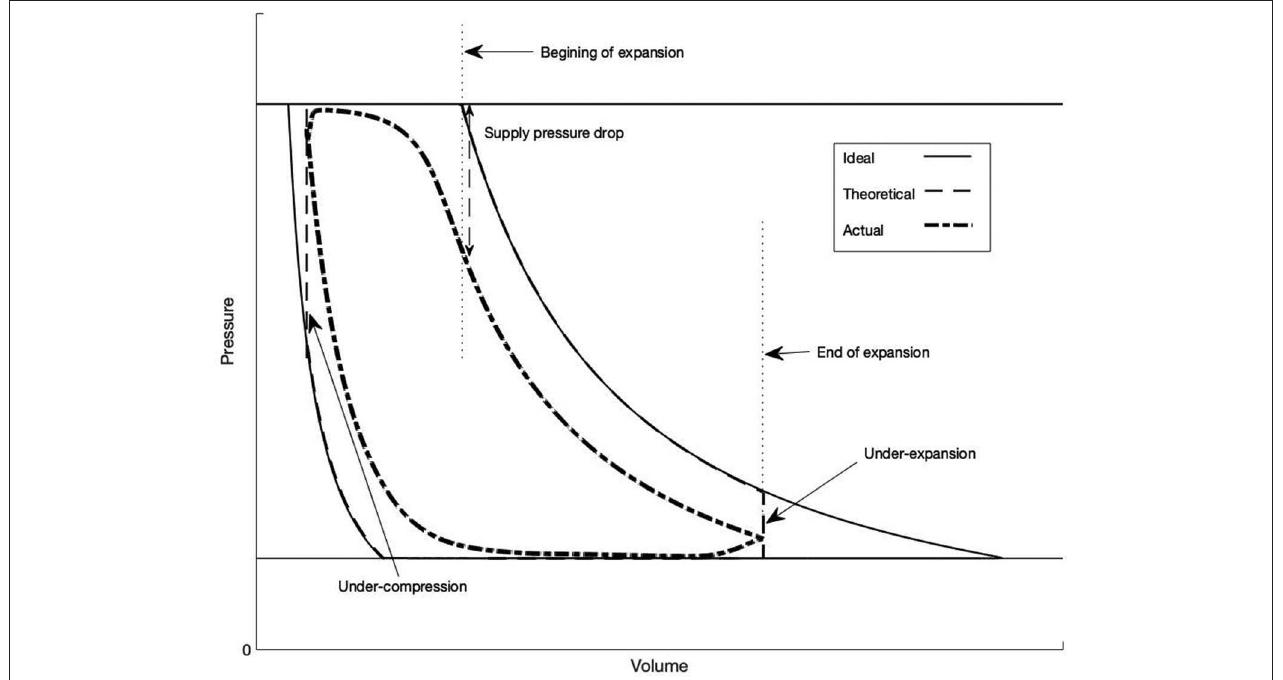
FIGURE 1 | Comparison between ideal, theoretical, and actual indicator diagram.